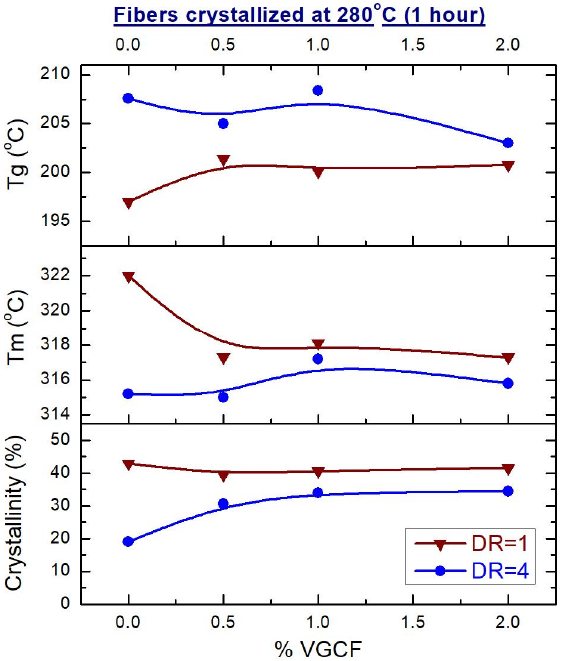
Figure 12. Concentration dependences of the glass transition and melting temperatures, as well as the degree of crystallinity of the crystallized composite fibers before (DR = 1) and after (DR = 4) orientational drawing on the VGCF content.